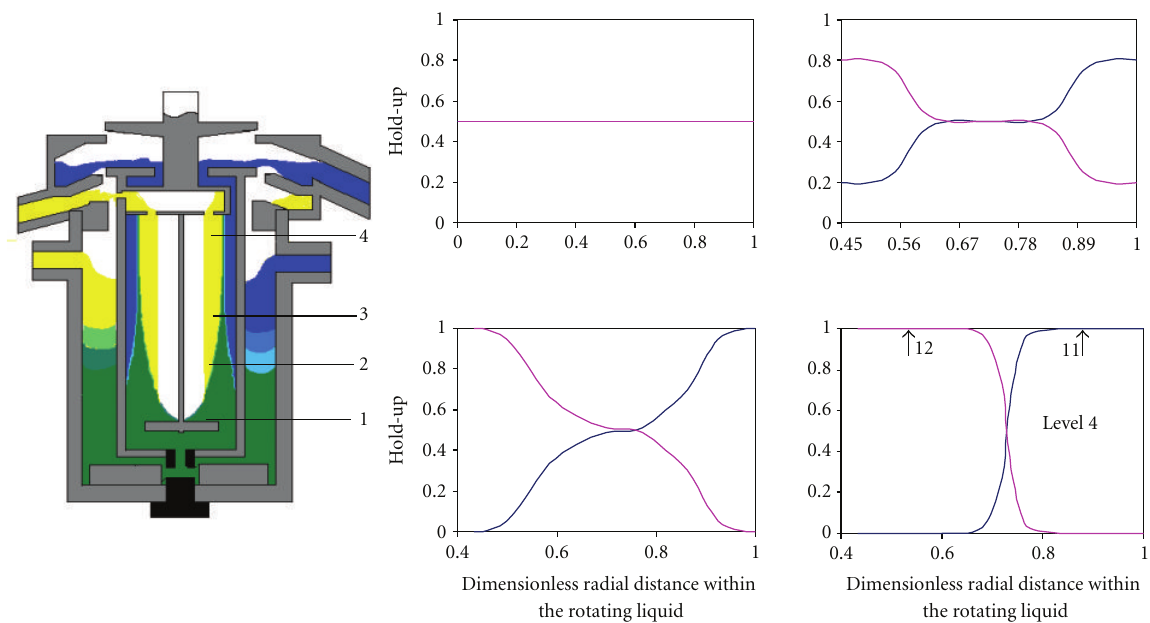
Figure 2: Variation of dispersion band in ACE